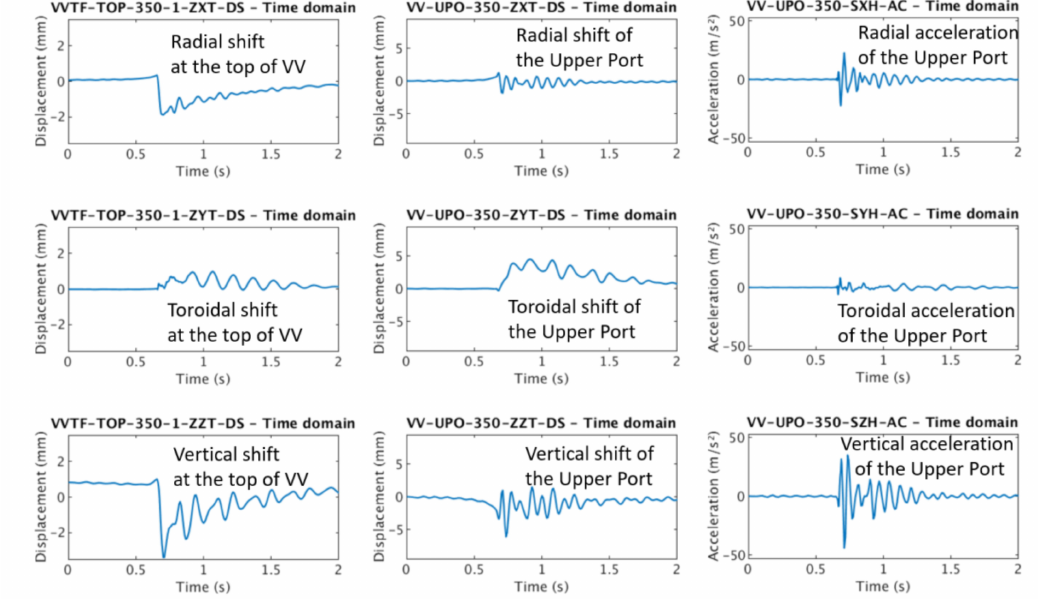
Figure 5. Dynamic simulations [7] demonstrate rather different characteristics of VV dynamic response in different spots: at the top of the VV and at the end of the regular upper port, both at one azimuth. This indicates a large role of bell-like vibration of VV structure. Vertical and radial aperiodic components associate mostly with direct EM loads, while lateral aperiodic- with asymmetric inertial response to symmetric EM excitation, and all periodic components- with various modes of inertial response. Courtesy of